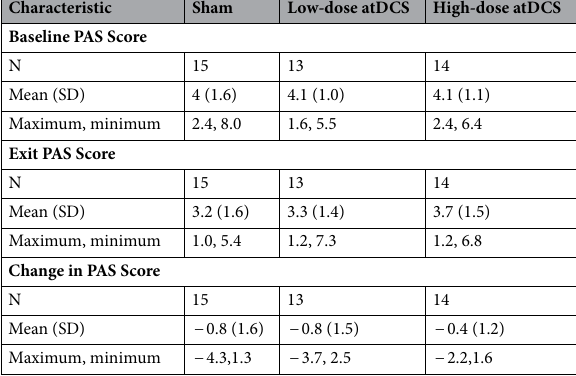
Table 3. Primary efficacy outcome-intent to treat analysis. Changes in the penetration-aspiration scale (PAS) Scores across sham and anodal transcranial direct stimulation (atDCS)